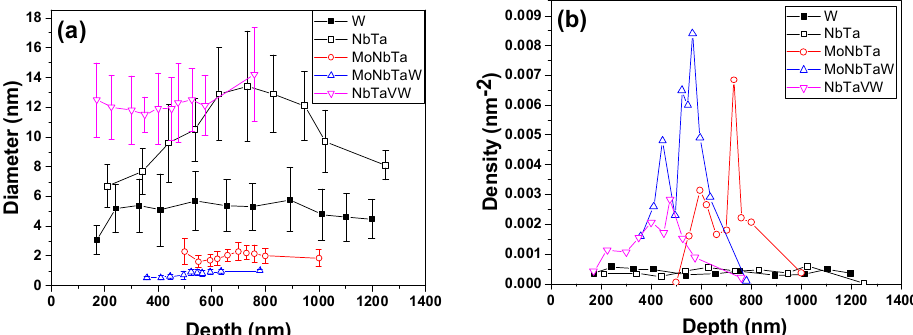
Figure 4. Average He bubble ( a ) diameter and ( b ) density as a function of depth beneath surface for all